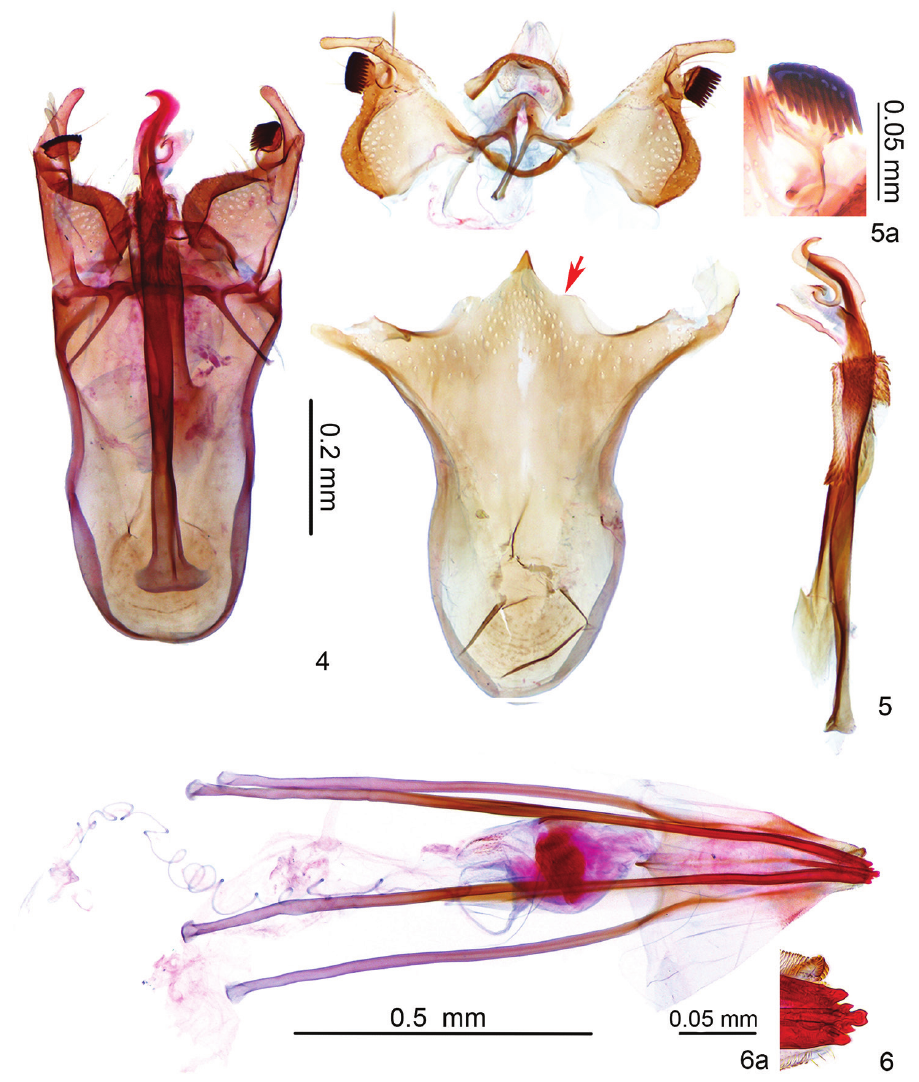
Figures 4–6. Genitalia of Antispila sinensis sp. n. 4 Male genitalia in situ , slide No. LTT12873, paratype 5 Male genitalia unrolled, slide No. LTT12872, paratype, red arrow referring to the region of the vinculum adjacent to the triangular median protrusion 5a Close-up of comb teeth on pecten, slide No. LIU15003 6 Female genitalia, slide No. LTT12875, paratype 6a Close-up of ovipositor tip, same slide as in Fig. 6.